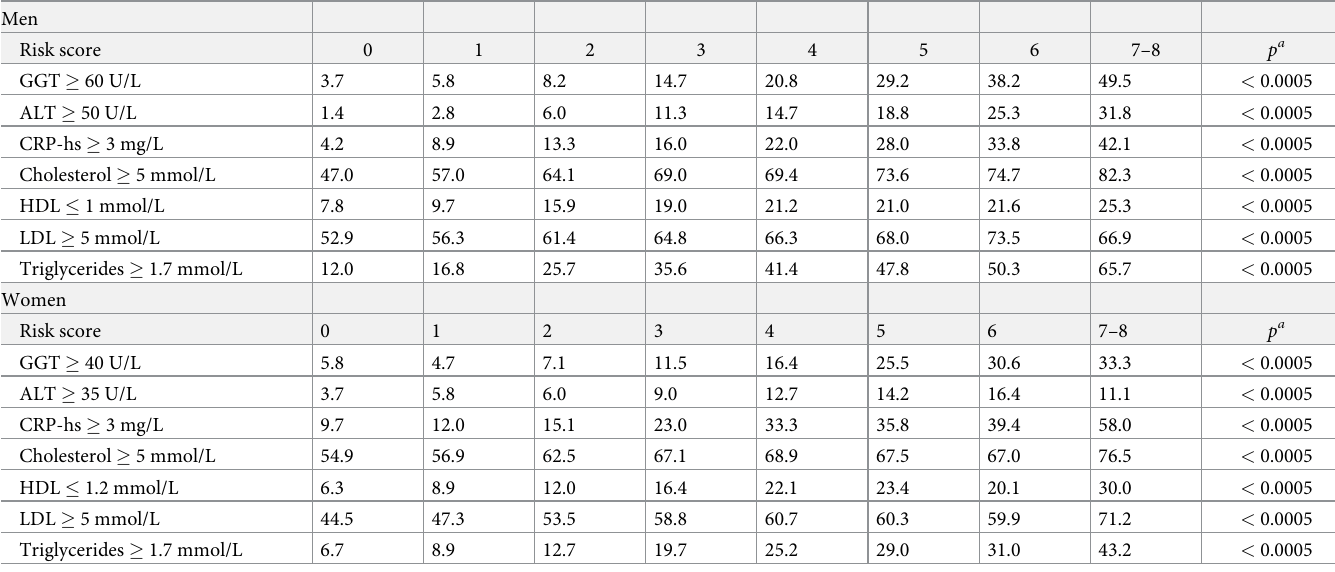
Table 2. The proportion (%) of abnormal biomarker findings in individuals classified according to the number of life-style associated risk factor scores. Men Risk